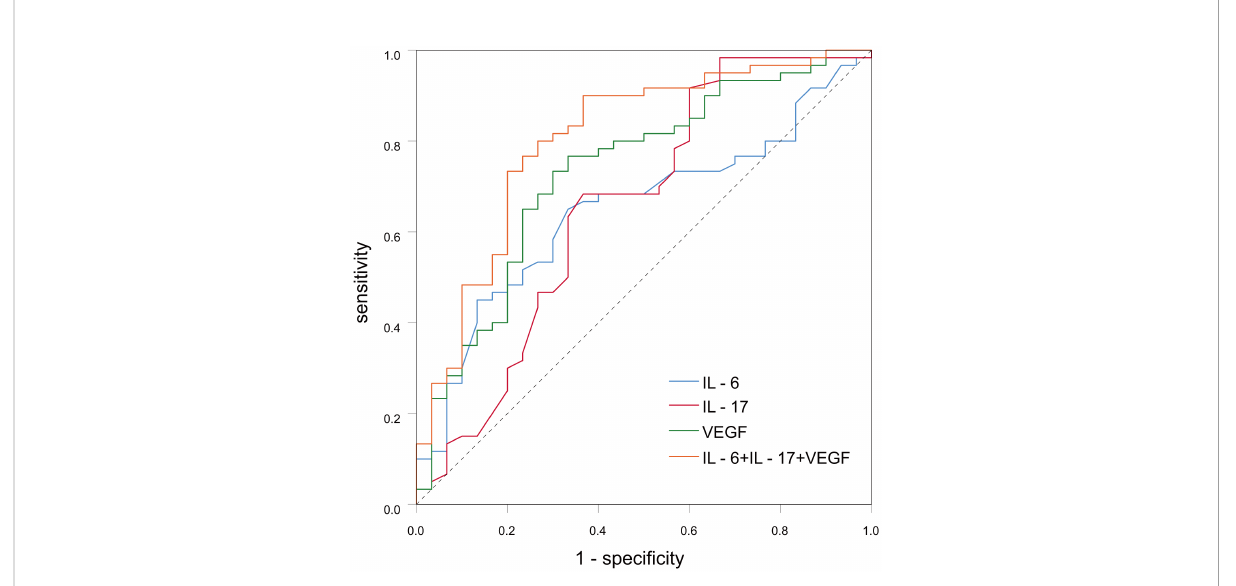
FIGURE 1 The curve graph of serum IL-6, IL-17, VEGF in breast cancer and benign breast disease patient.